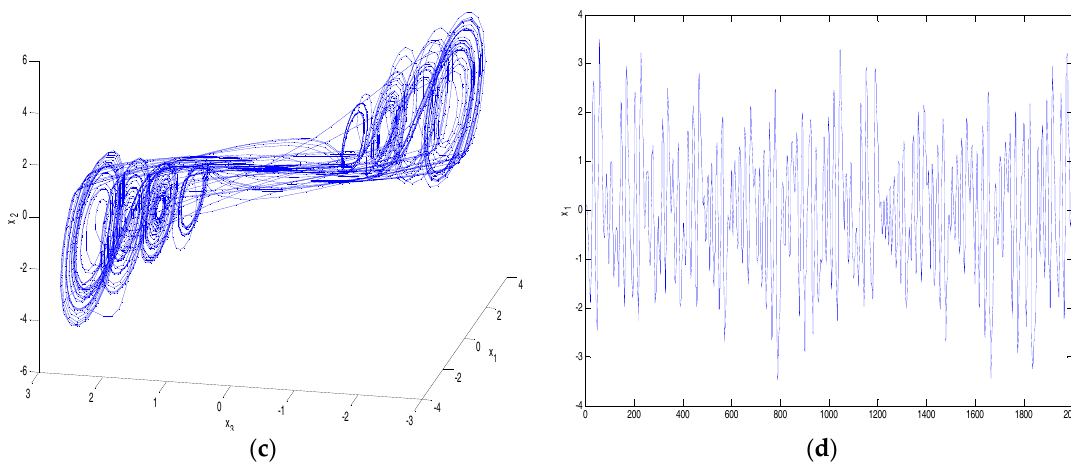
Figure 5. Numerical results of the 1 ‐ D multi ‐ scroll SC ‐ CNN Based system: ( a ) 2 ‐ double scrollin x 1 ‐ x 2 ‐ x 3 plane; ( b ) time response of x 1 (t) dynamic for 2 ‐ double scroll; ( c ) 4 ‐ double scrollin x 1 ‐ x 2 ‐ x 3 plane; and ( d ) time response of x 1 (t) dynamic for 4 ‐ double scroll.